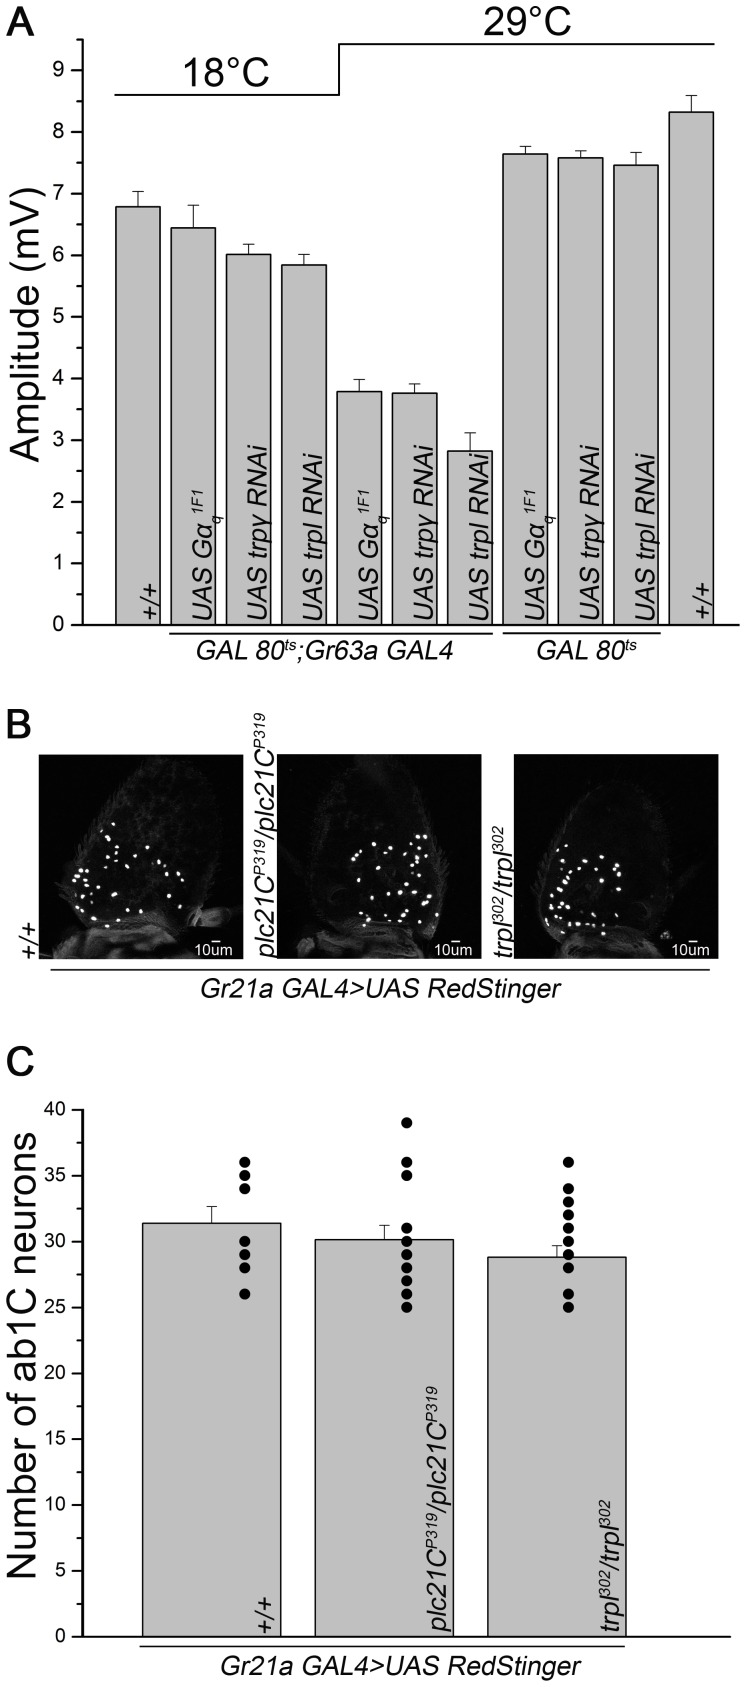
Reduced sensitivity to CO2 is not a developmental defect.A) RNAi lines grown at the restrictive temperature of 18°C (active GAL80) show normal electrophysiological responses to CO2, since the CO2 receptor neuron specific GAL4 remains inactive (absence of RNAi expression; p>0.05). RNAi lines grown at the permissive temperature of 29°C (inactive GAL80) show reduced electrophysiological responses to CO2 due to active GAL4 and RNAi expression (n = 10; p<0.0001). The RNAi heterozygotes in the absence of Gr63aGAL4 show normal responses to CO2 at 29°C. Error bars indicate SEM. B) Whole antennal mounts showing CO2 sensory neurons marked using UAS RedStinger driven by Gr21aGAL4 in wild type, plc21CP319/plc21CP319 and trpl302/trpl302 mutant lines. C) Quantification of CO2 sensory neurons in the adult antennae of the same lines (n = 14; p value not statistically significant).